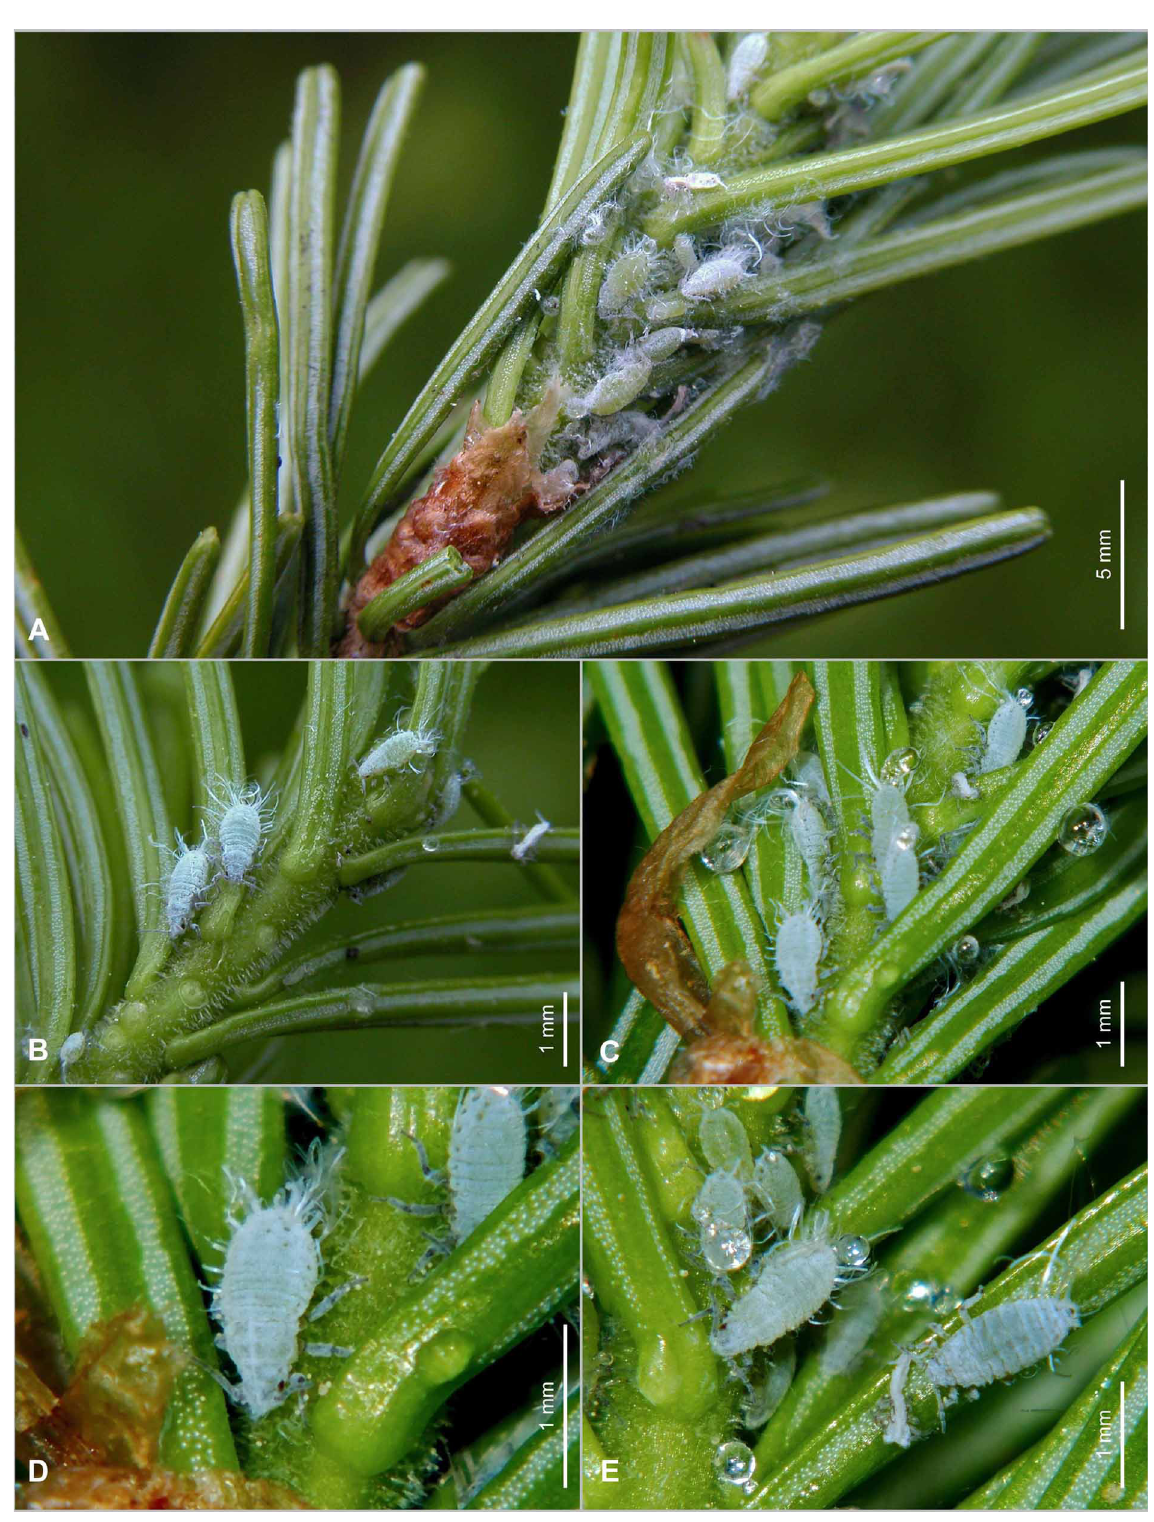
Fig. 48. Mindarus abietinus (Koch, 1857) on Abies sibirica. Colony on young shoot, mostly juvenile